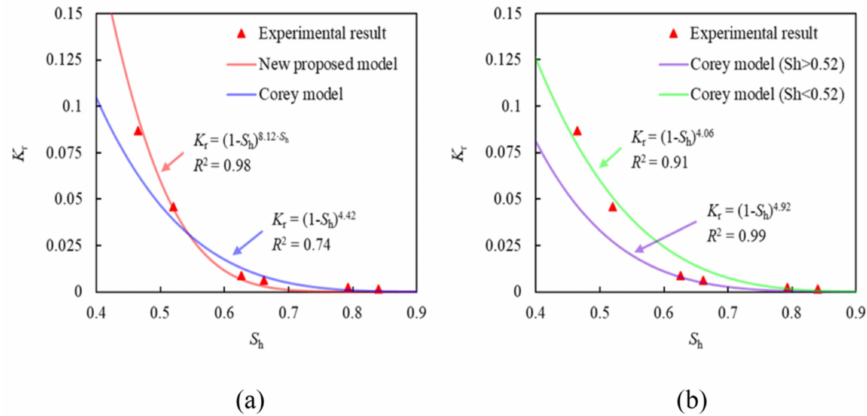
Figure 23. The relative permeability data for xenon hydrate-bearing sediments reprinted from [66] with permission from Elsevier. ( a ) Simple Corey model fit (blue solid line) and new proposed model fit (red solid line); ( b ) simple Corey model fit with different exponent N